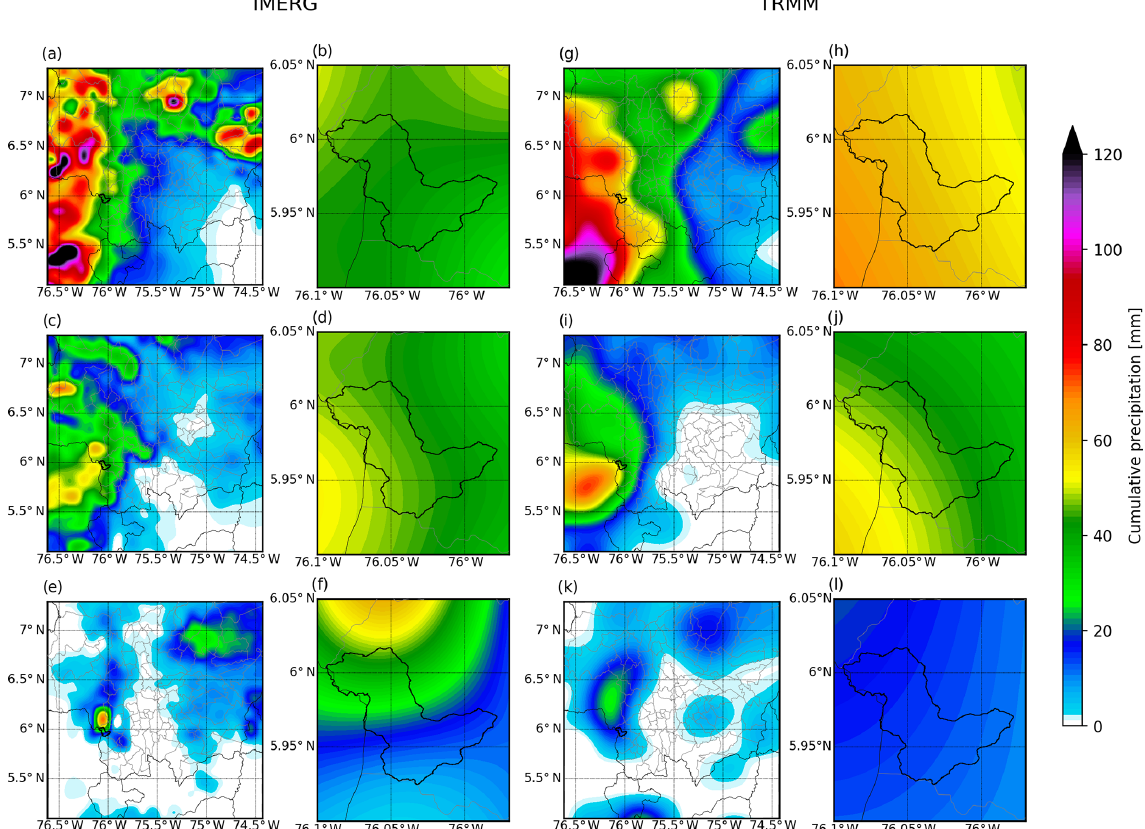
Figure 16. Same as Fig. 10 for the IMERG (a–f) and TRMM 3B42 (g–l) products.